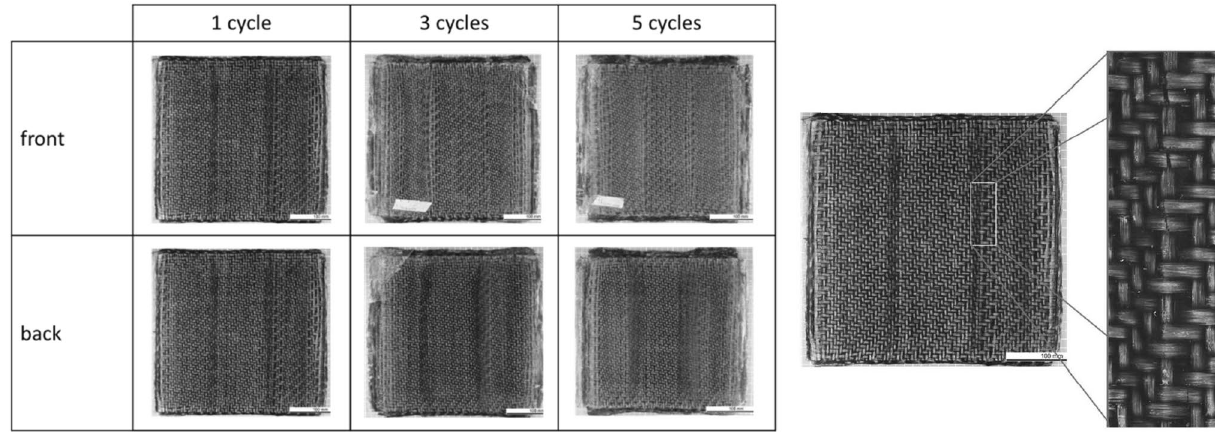
Fig. 5 Results of the optical examination for PPGF material after process variant 1